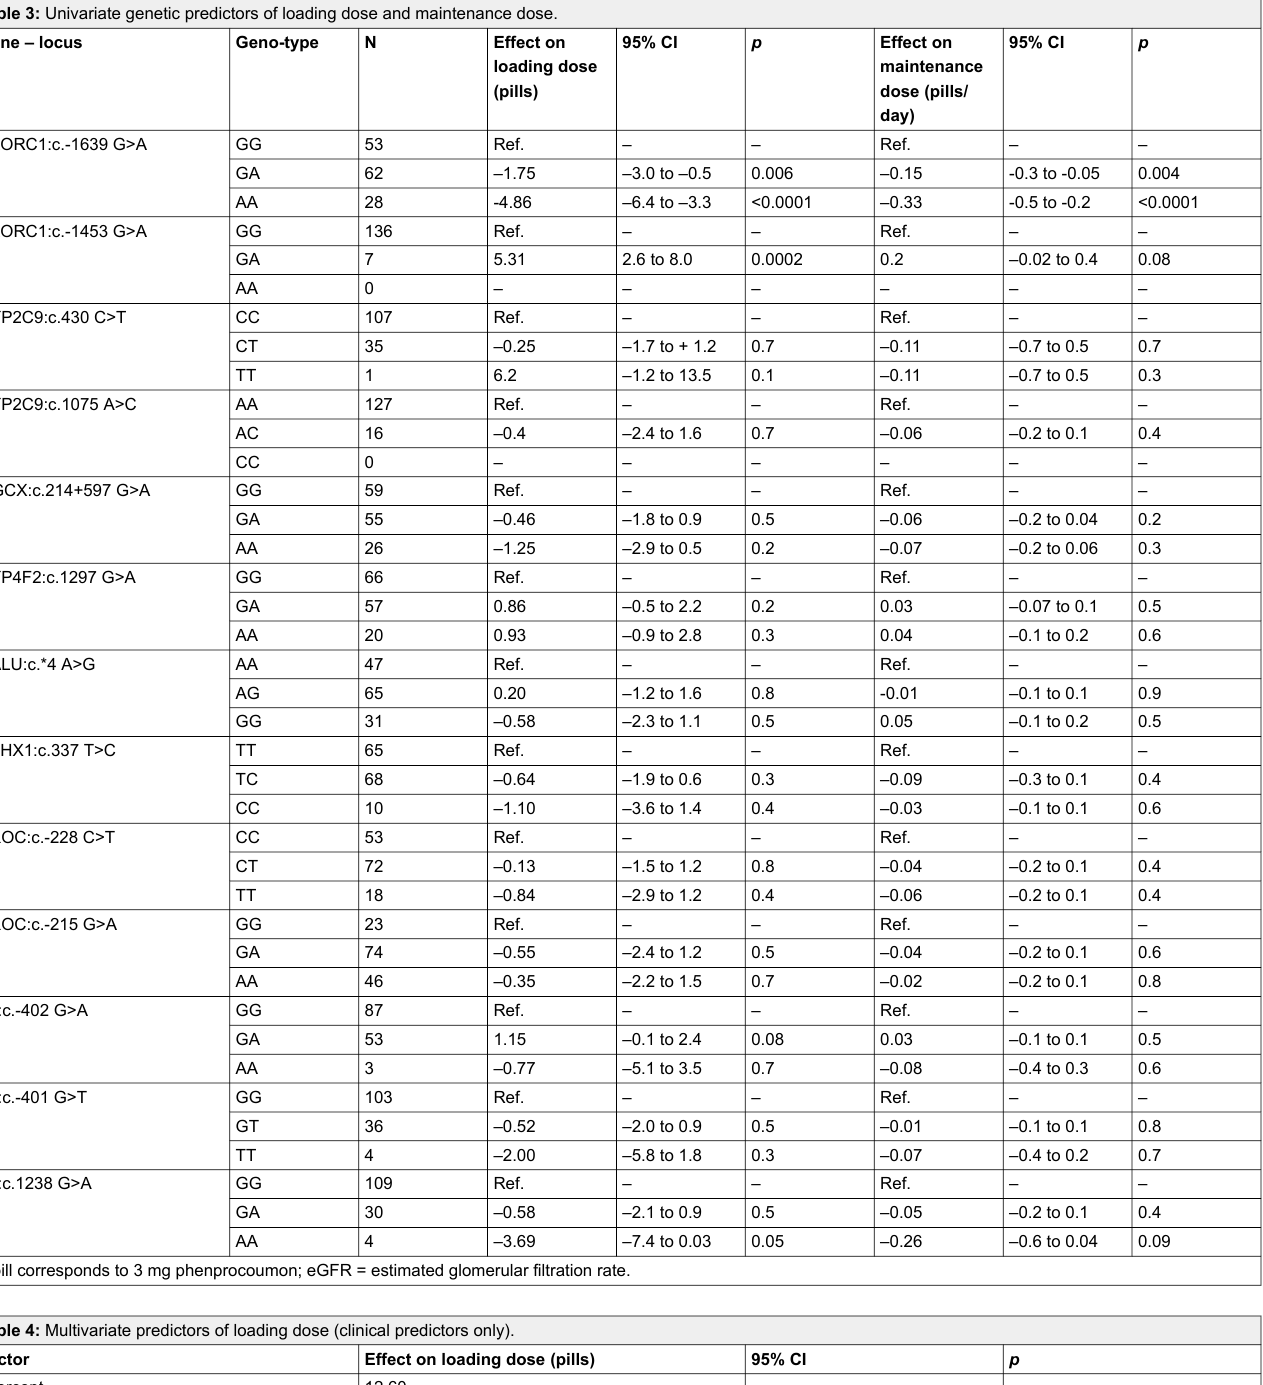
Table 3: Univariate genetic predictors of loading dose and maintenance dose. Gene – locus